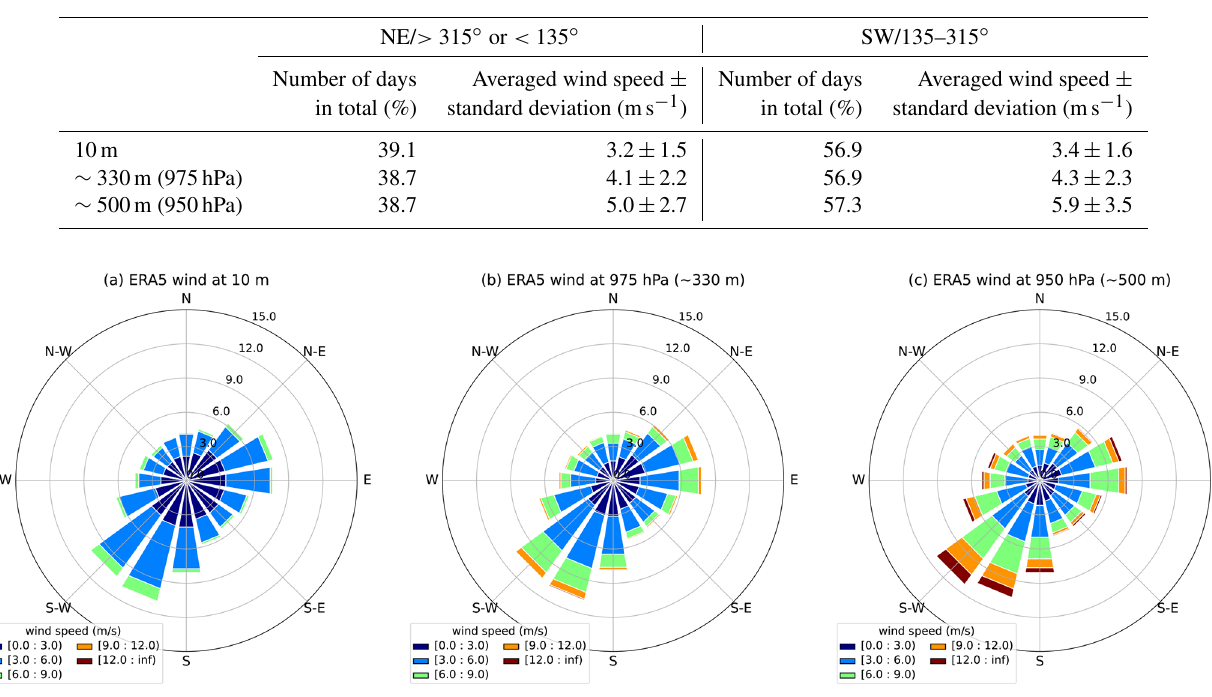
Figure 3. Wind rose plots for daytime (08:00–18:00UTC) from November 2017 to December 2020 for the ERA5 model wind at different vertical levels (10, ∼ 330 and ∼ 500m). The days for the 3-year average coincide with the TROPOMI overpass